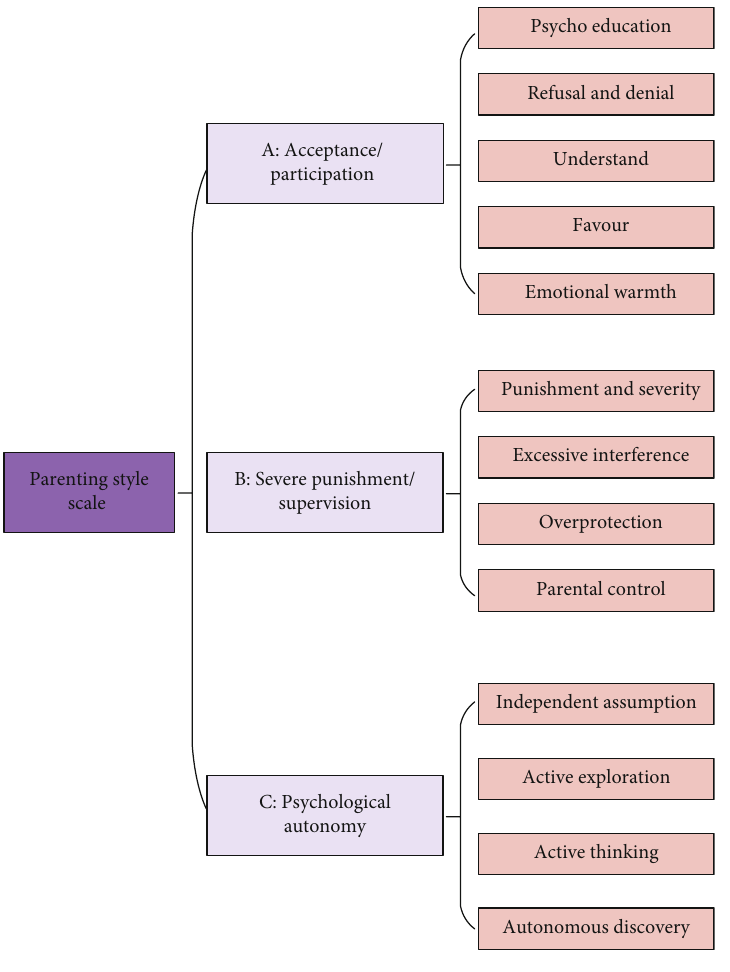
Figure 3: Parenting style